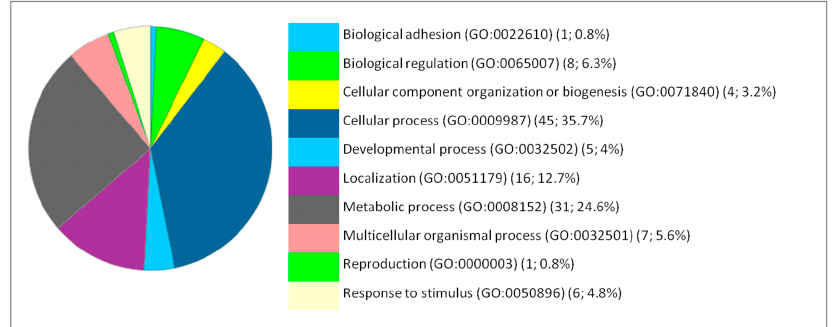
Figure 1. Functional classification of the 127 differentially expressed proteins in the brain following IONP exposure according to the biological processes. The pie chart was generated from PANTHER Classification System. The number and percentage are given based on the 127 proteins. Biological process name (GO: Gene Ontology class ID) (number of proteins; percentage from 127 proteins).